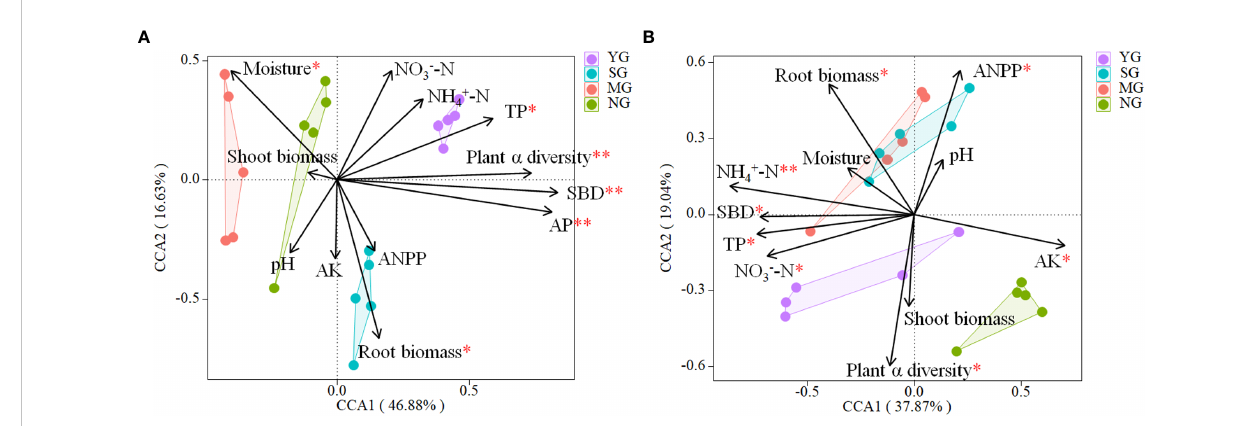
FIGURE 4 Canonical correspondence analysis using pooled data of bacterial (A) and fungal (B) communities and abiotic and biotic variables (arrows). The values of Axis 1 and 2 are percentages that the corresponding axis can explain. TC, soil total carbon; TN, soil total nitrogen; C/N, carbon/nitrogen; TP, soil total phosphorus; NO − 3 -N, soil nitrate; NH + 4 -N, soil ammonium; AP, soil available phosphorus; AK, soil available potassium; SBD, soil bulk density; ANPP, above-ground net primary productivity. YG, Yak grazing; SG, Tibetan Sheep grazing; MG, Yak and Tibetan sheep mixed grazing; NG, No grazing.